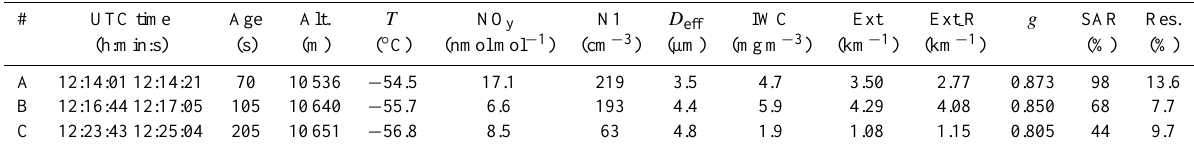
Table 1. Mean parameter values in the indicated time-intervals and corresponding contrail ages for the three selected contrail regions A, B and C (see Fig. 2). The parameters are: age, altitude, temperature T , NO y mixing ratio, concentration of particles ( d > 0 . 9µm), effective diameter D eff , ice water content IWC, direct (PN) and retrieved extinction coefficients (Ext and Ext R , respectively), asymmetry parameter g , spherical/aspherical partitioning ratio (SAR) and residual